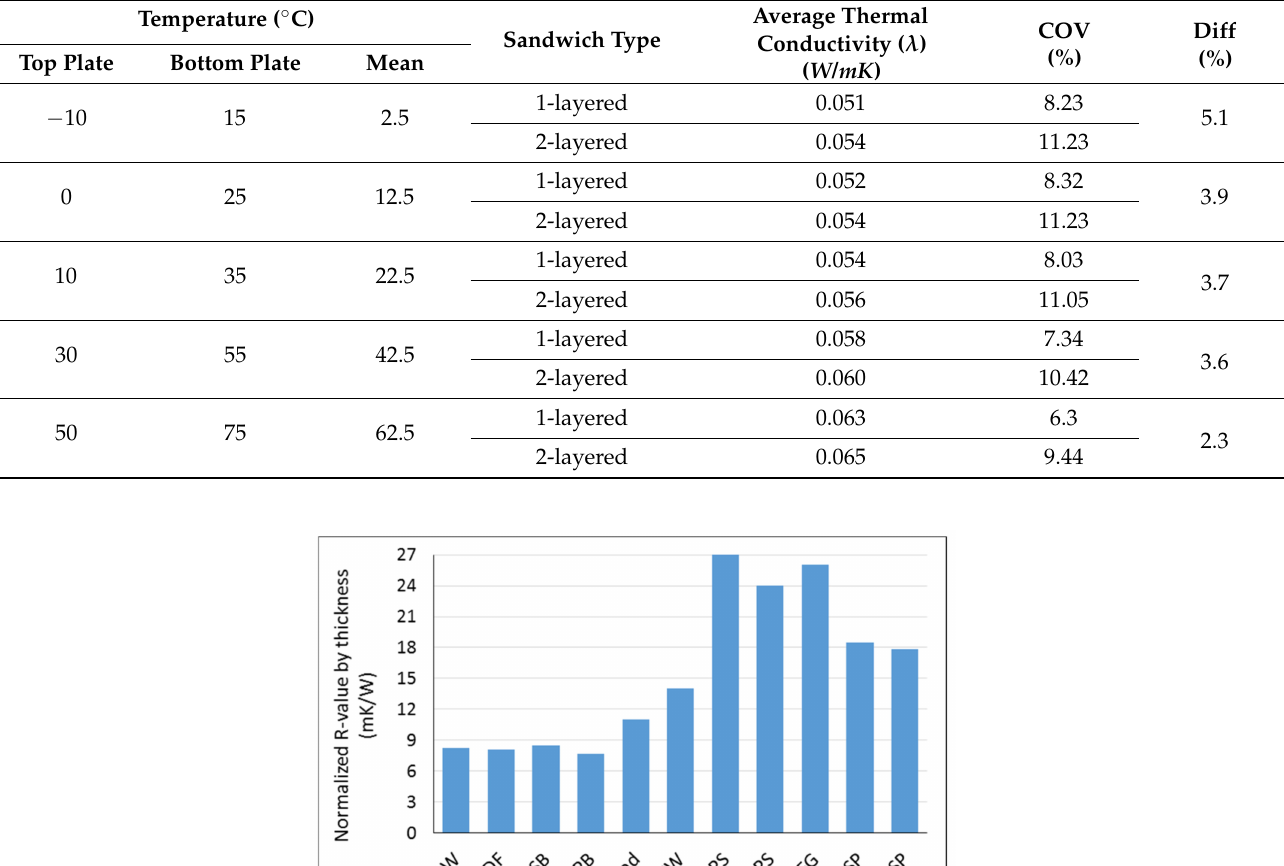
Table 3. Comparison of normalized thermal conductivity of one- and two- layered core sandwich panels.